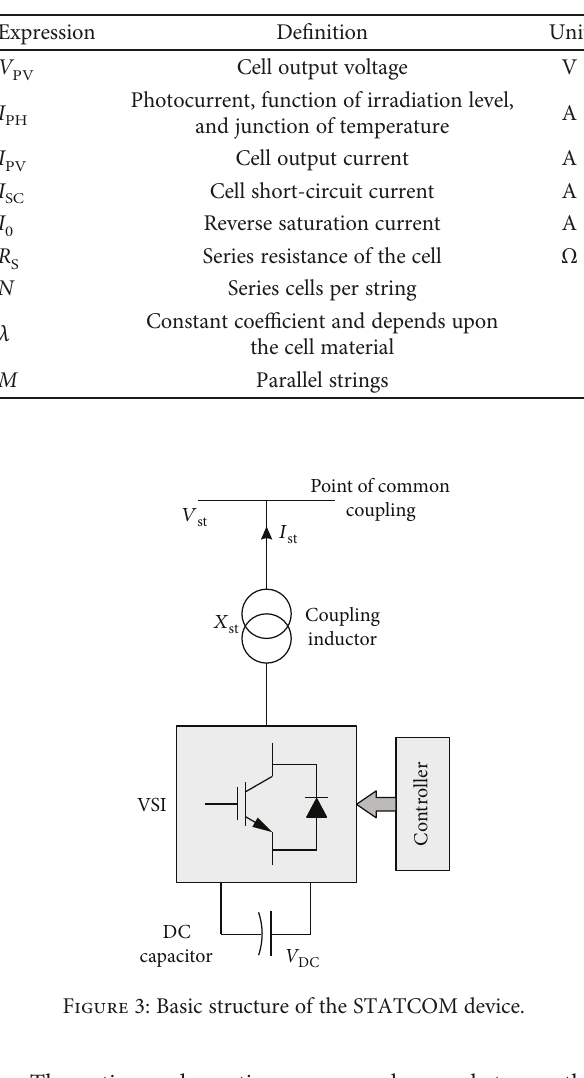
Table 1: The descriptions for the PV cell.